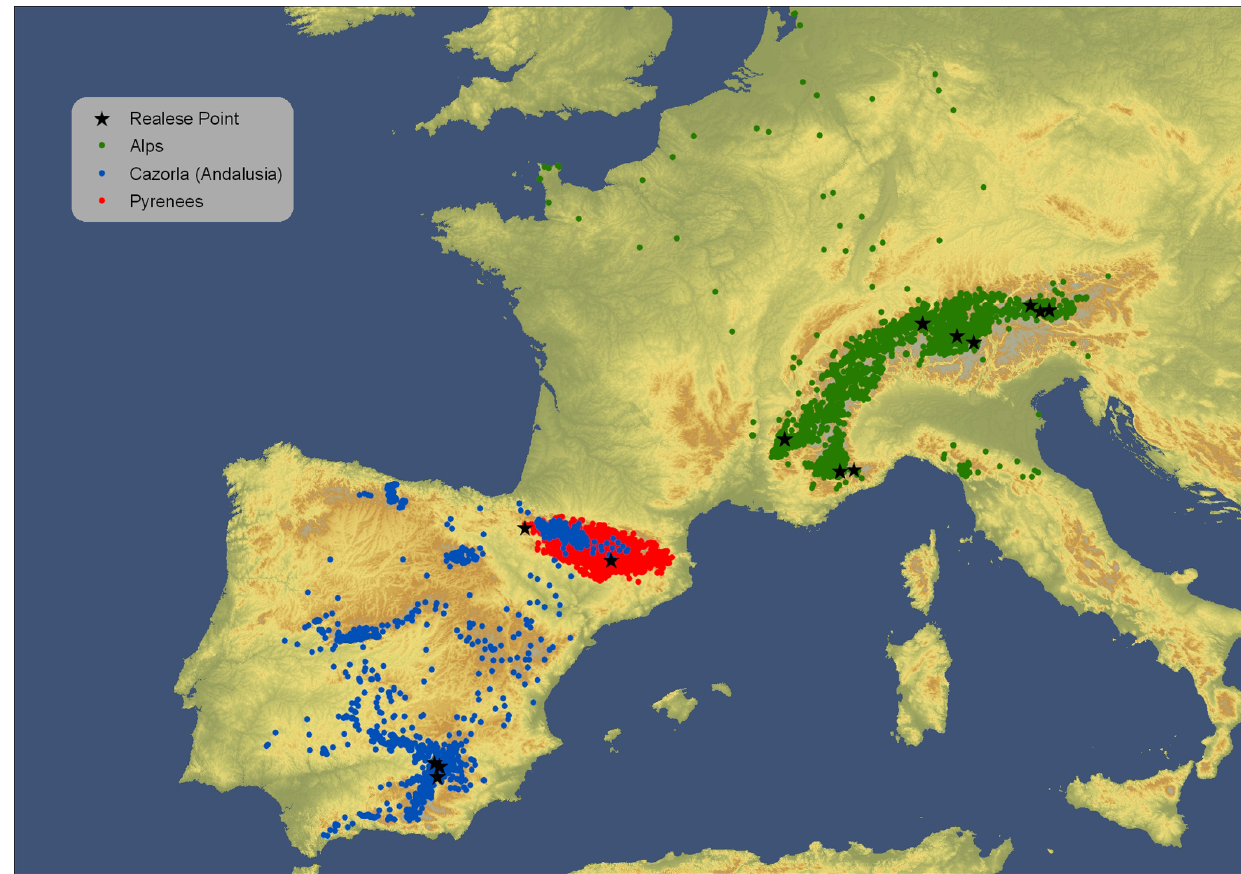
Figure 1. Distribution of mean-day locations of individual satellite-tracked pre-adult bearded vultures of the wild Pyrenean population ( n =9), and the reintroduced populations of Andalusia ( n =13) and the Alps ( n =24). Stars show release points.